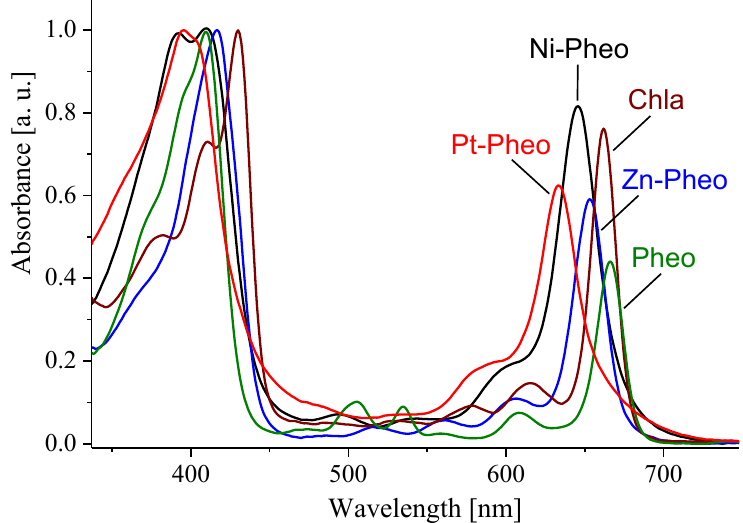
Figure 3. Electronic absorption spectra of Pheo and its complexes with Mg 2+ , Zn 2+ , Ni 2+ , and Pt 2+ , recorded at ambient temperature in acetone. The spectra were normalized to the Soret bands’ maxima.